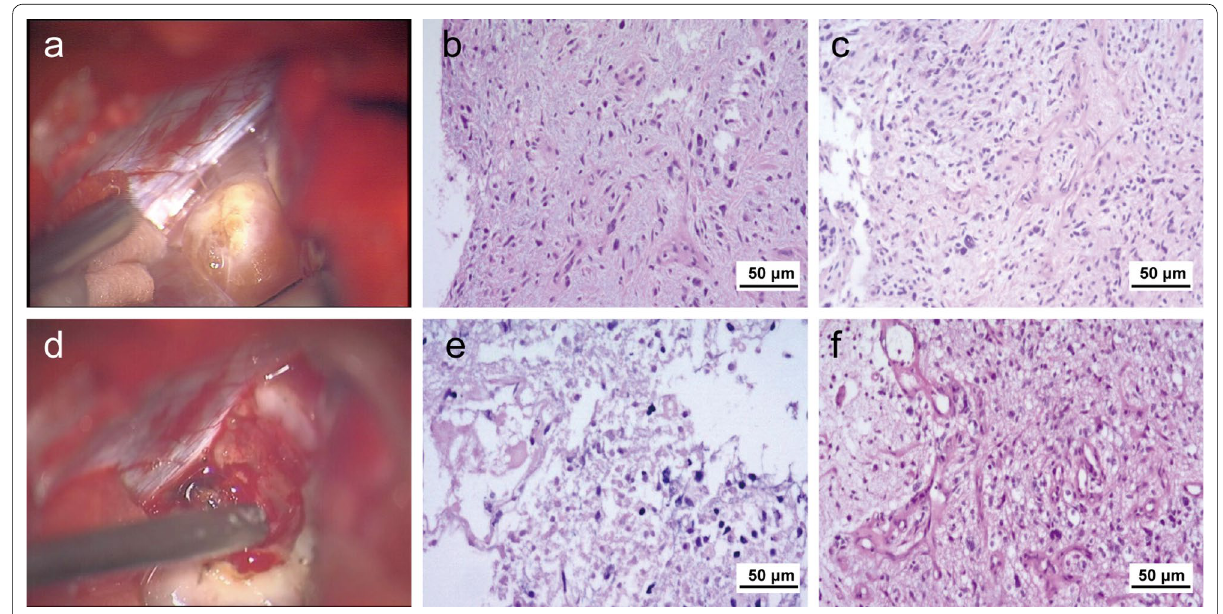
Fig. 3 Histopathologic examination of the CPA lesion with hematoxylin–eosin staining. a Macroscopically, the outer layer of CPA lesion is rubbery and nodule-like. b Under a microscope, the outer layer of the CPA lesion displays moderate mitoses and necrosis. c Under a microscope, the outer layer of the CPA lesion displays moderate vascularization. d Macroscopically, the internal portion of the lesion is softer and has a higher blood sup- ply than the outer layer. e Under a microscope, the internal portion of the CPA lesion displays obvious mitoses and necrosis. f Under a microscope, the internal portion of the CPA lesion displays